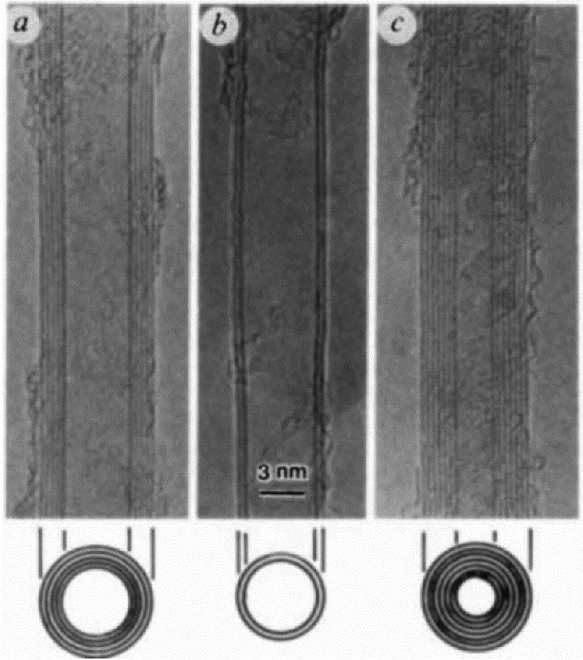
Figure 1: Electron micrographs of microtubules of graphitic carbon. ( a ) Tube consisting of fi ve graphitic sheets; ( b ) two - sheet tube, diameter; and ( c ) seven - sheet tube [ 43 ] .